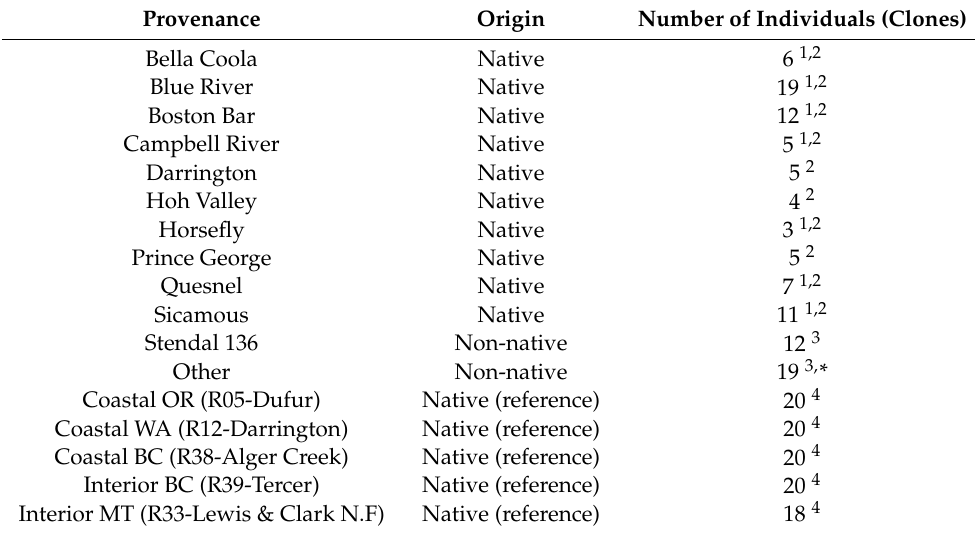
Interior MT (R33-Lewis & Clark N.F) Native (reference) 18 4 1 Genotypes selected in the provenance trial plot S2265 Bruzaholm. 2 Genotypes selected in the provenance trial plot S2266 Tönnersjöheden. 3 Genotypes selected in the progeny test of Danish clones. 4 Origin of